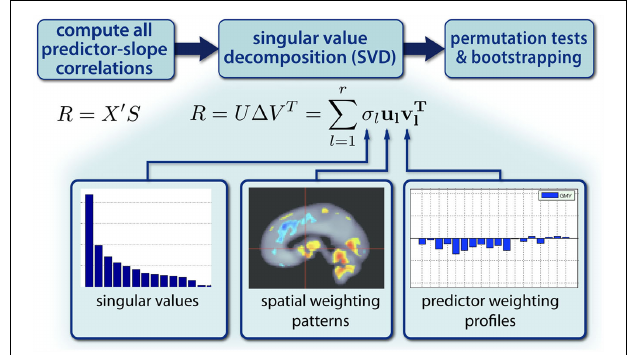
FIGURE 8 | Partial least squares correlation (PLSC) approach for analysis of inter-individual variability of decline parameters. PLSC decomposes the correlation structure of change parameters S and predictors X using singular value decomposition (SVD).This reveals pairs of spatial weighting patterns and predictor